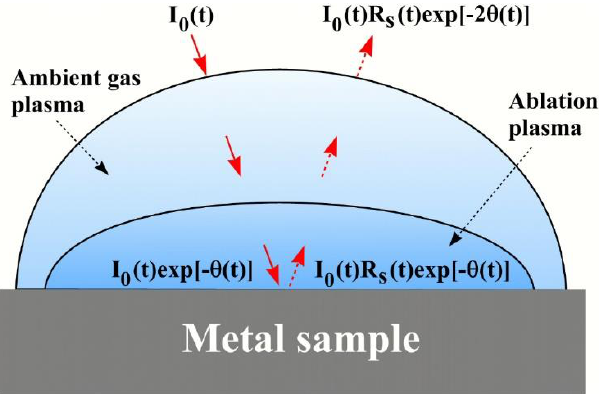
Figure 4. Schematics of laser-induced plasmas and reflection of the laser pulse from the sample- plasma system, where I 0 (t) is the incident laser pulse power, I 0 (t)exp [−θ(t)] is the laser pulse plasma system, where I 0 ( t ) is the incident laser pulse power, I 0 ( t ) exp [ − θ ( t )] is the laser pulse power power that arrives at the sample surface, θ(t) is the total optical thickness of the plasma, that arrives at the sample surface, θ ( t ) is the total optical thickness of the plasma, I 0 ( t ) R s ( t ) exp [ − θ ( t )] I 0 (t)R s (t)exp[−θ(t)] is the laser pulse power reflected from the sample surface, R s (t) is the reflec- is the laser pulse power reflected from the sample surface, R s ( t ) is the reflectivity of the sample tivity of the sample surface, and I 0 (t)R s (t)exp [−2θ(t)] is the laser pulse power that escapes the surface, and I 0 ( t ) R s ( t ) exp [ − 2 θ ( t )] is the laser pulse power that escapes the sample-plasma sample-plasma system.